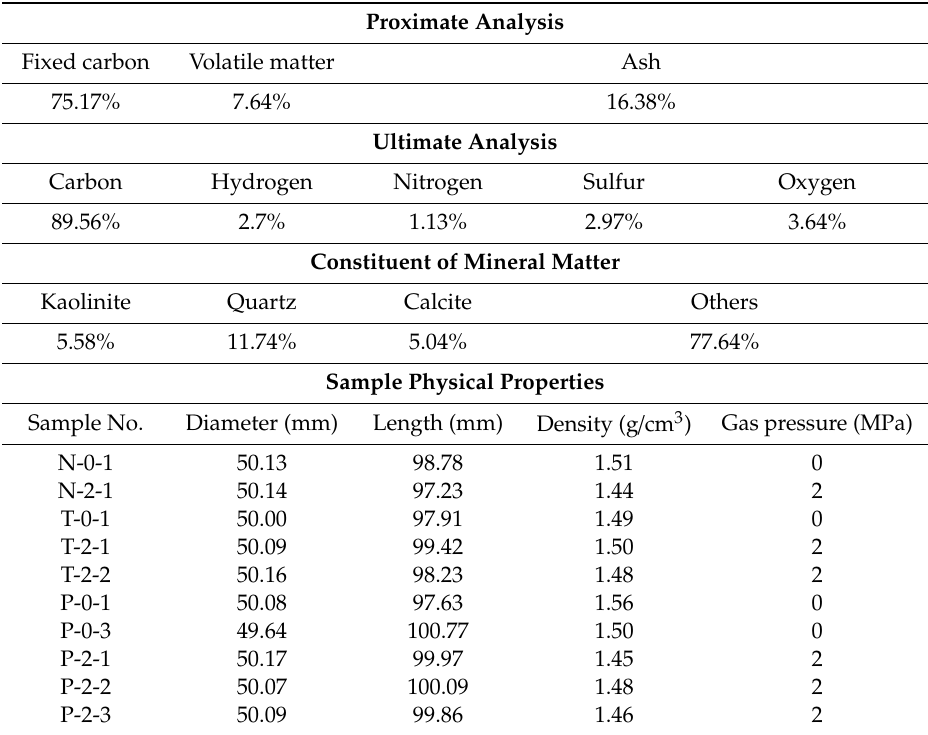
Table 1. Properties of the Baijiao anthracite samples